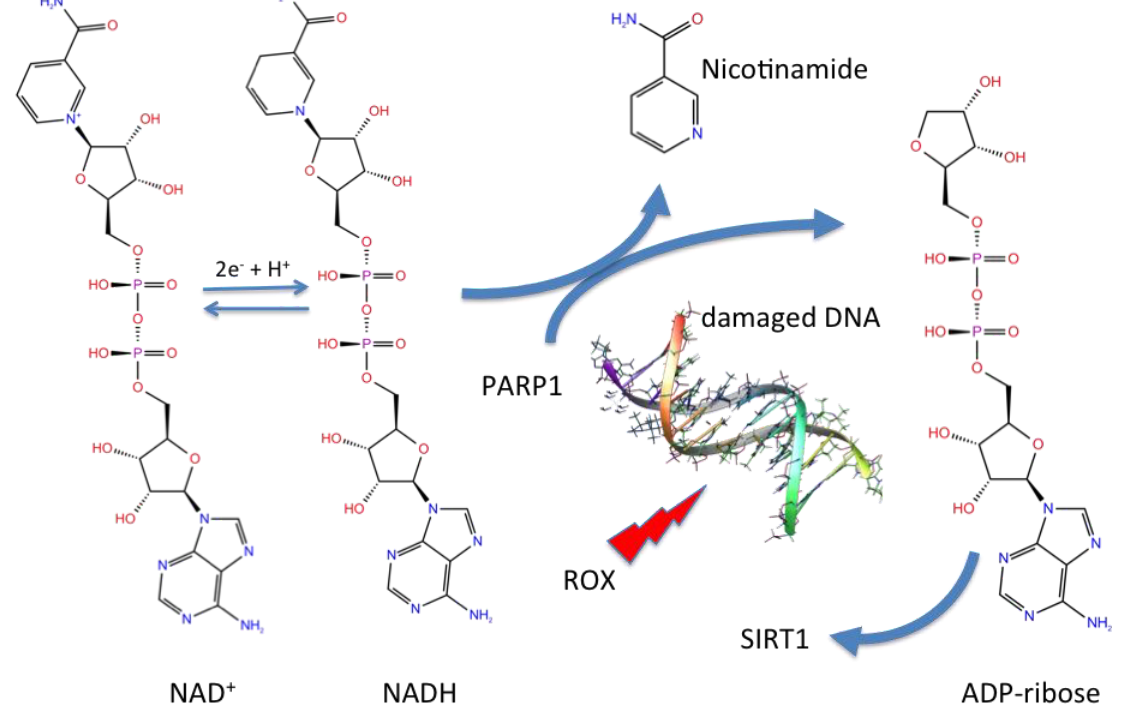
Figure 6. Nicotinamide adenine dinucleotide (NAD) redox equilibrium and its role in DNA repair. DNA damage activates the PARP1 enzyme, resulting in consumption of nicotinamide adenine dinucleotide (NAD + ) as a substrate to produce ADP-ribose units.